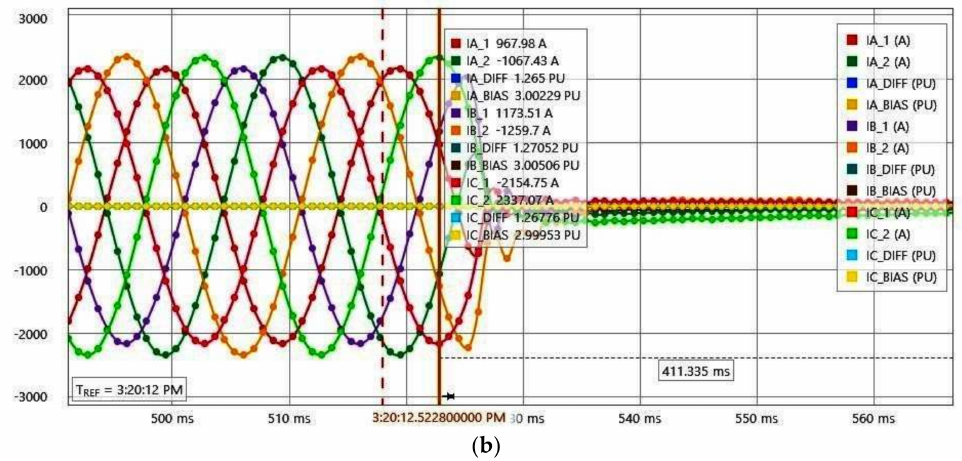
Figure 9. Waveforms of bias characteristics for points selected in Figure 11a: ( a ) point B, ( b ) point F.